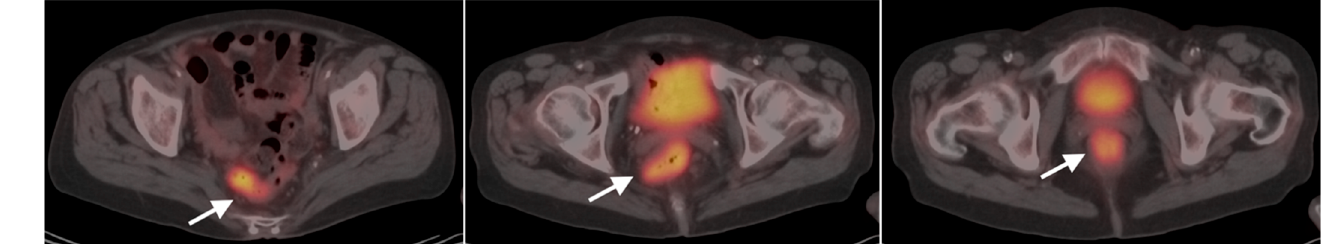
Figure 34. Ulcerative colitis. Axial fused PET-CT images of the pelvis. Hypermetabolic thickened and featureless appearance of the bowel wall extending to the rectum (white arrows) are typical for active ulcerative colitis.